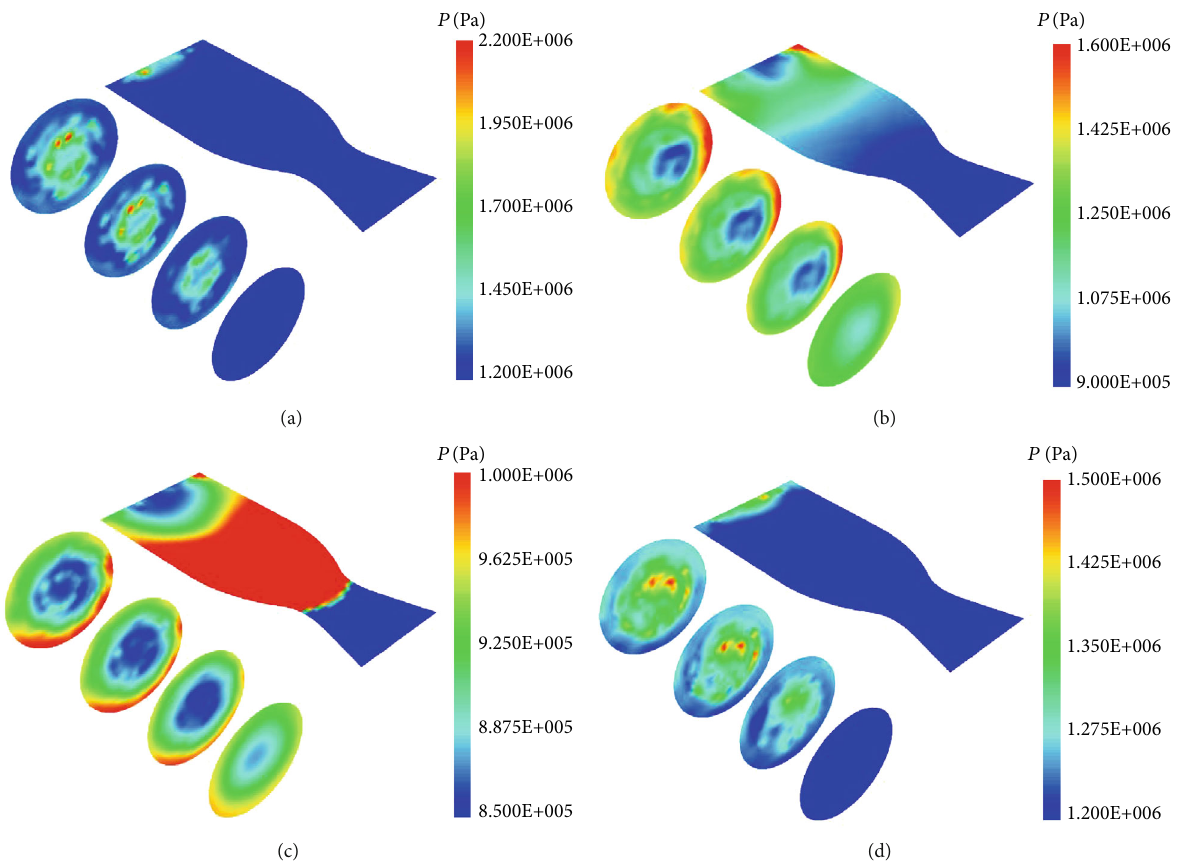
Figure 7: The time evolution of pressure contours in Case 2. (a) 6.70327ms. (b) 6.73222ms. (c) 6.78189ms. (d)